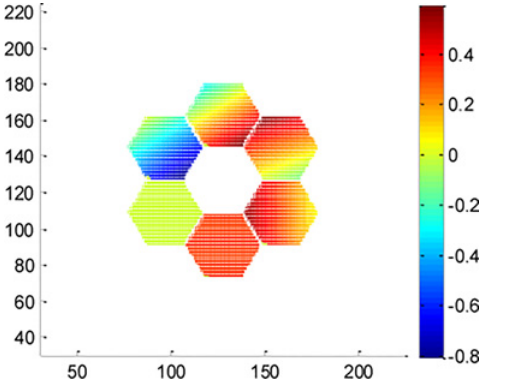
Fig 3. Phase distribution of original distorted wavefront of the resolution test panel experiment.